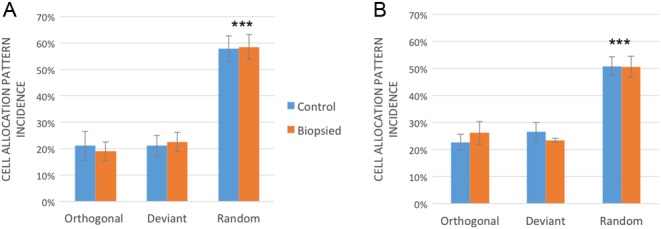
Incidence of different cell allocation patterns across control and biopsied mouse embryos. (A) Cell allocation pattern incidence in B6CBAF1 × B6CBAF1 blastocysts. (B) Cell allocation pattern incidence in B6C3F1 × B6D2F1 blastocysts. ***Denotes statistical difference P < 0.001.